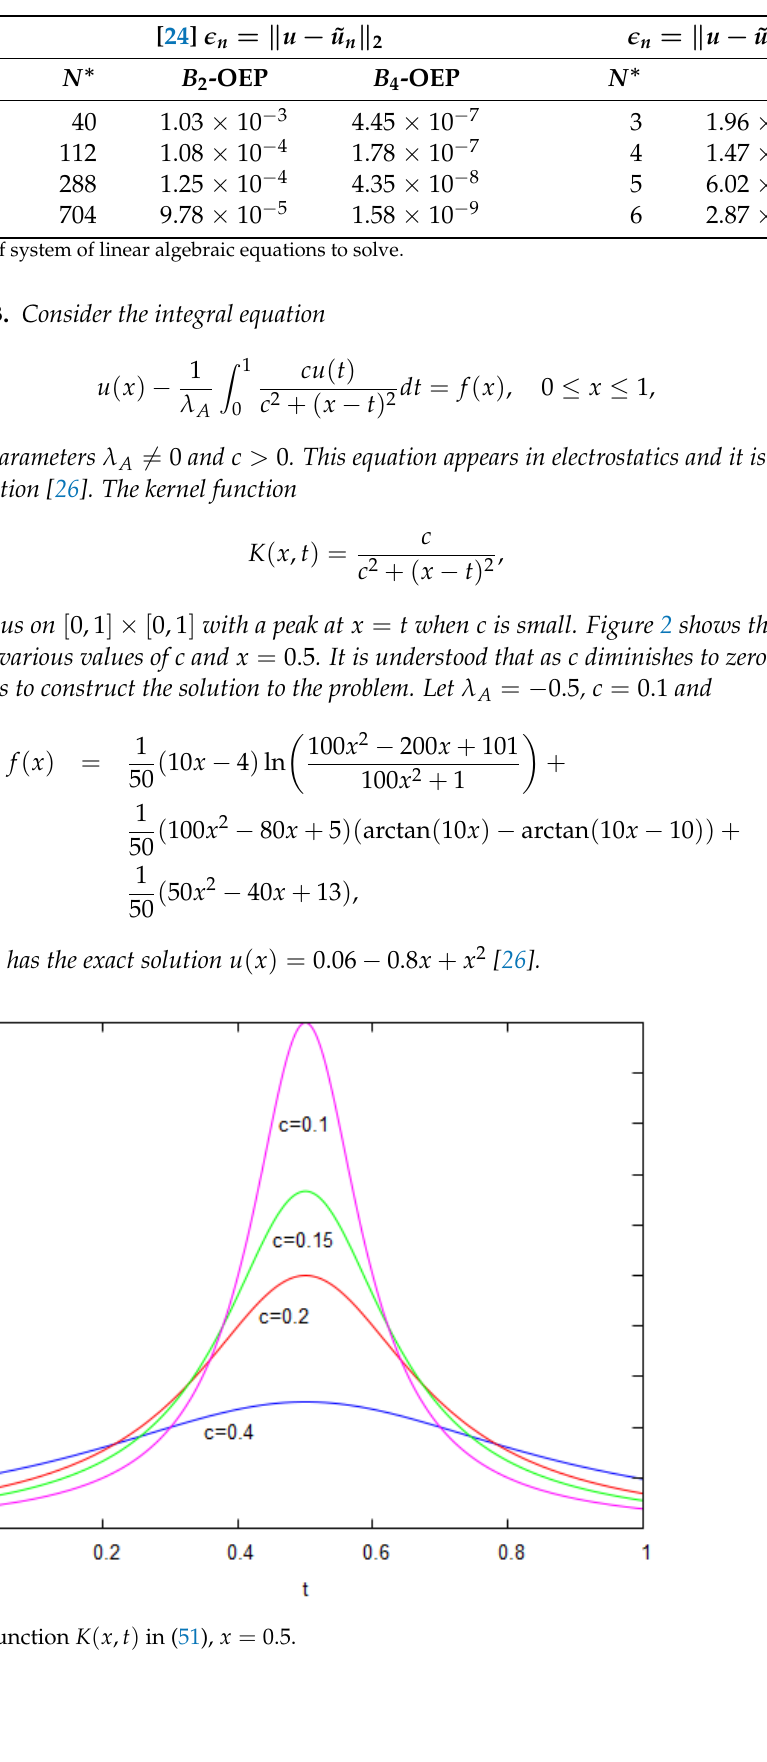
Table 9. IE (48), λ A = 1: PM: Collocation with Polynomials.